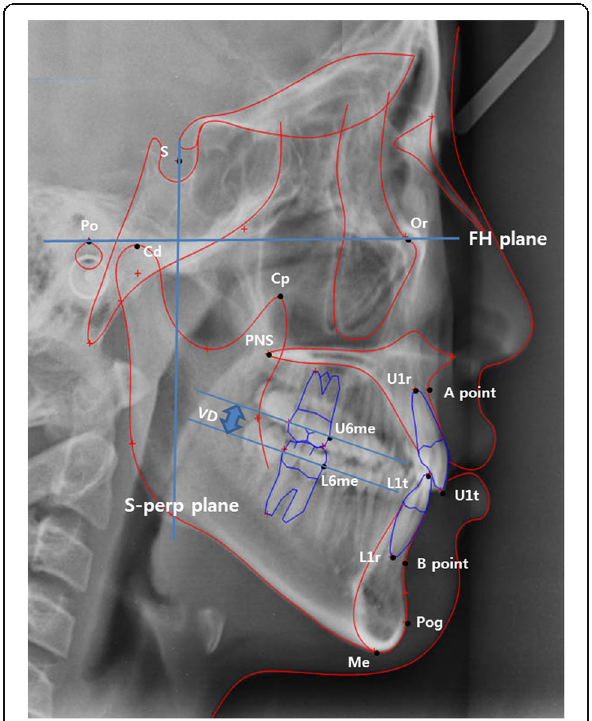
Fig. 1 Landmarks and linear measurements. The distances were measured from the Frankfort-horizontal (FH) plane ( vertical ) and the Sella-perpendicular (S-perp) plane ( horizontal ) to each landmark. Condylion ( Cd ): most superior point of condyle head. Coronoid process ( Cp ): tip of coronoid process. U1t and L1t : upper and lower 1 st incisor tip. U1r and L1r : upper and lower 1 st incisor root apex. U6mc and L6mc : upper and lower 1 st molar mesial contact. Occlusal vertical dimension ( VD ): distance between mesial contact points of upper-right 1 st molar and lower-right 1 st molar as projected onto the S-perp